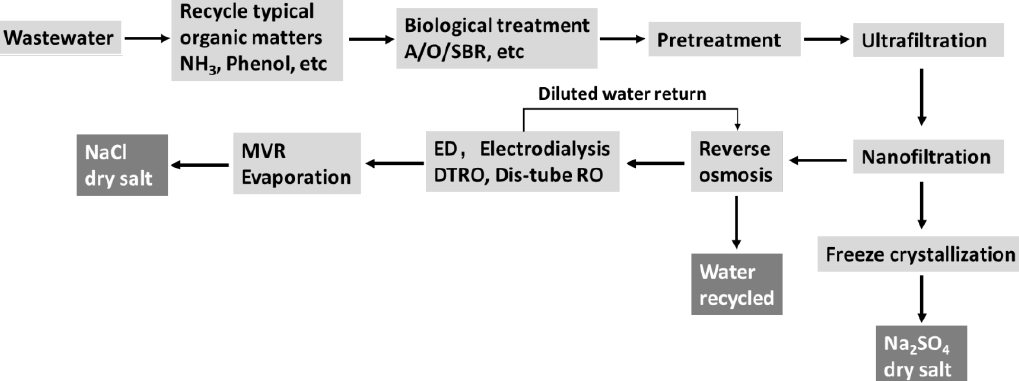
Figure 1. A typical zero liquid discharge wastewater treating procedure. Table 1. Estimation of waste salt discharge capacity from the coal chemical industry in China a .